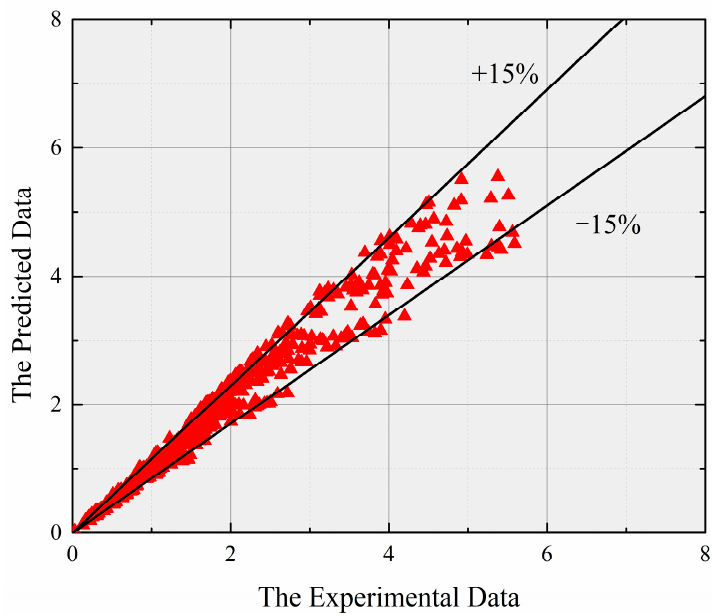
Figure 13. Comparison of the experimental Δ P f and the calculated results based on modified correlation. Table 4. Comparison of the results of the newly modified correlation and Dukler correlation.